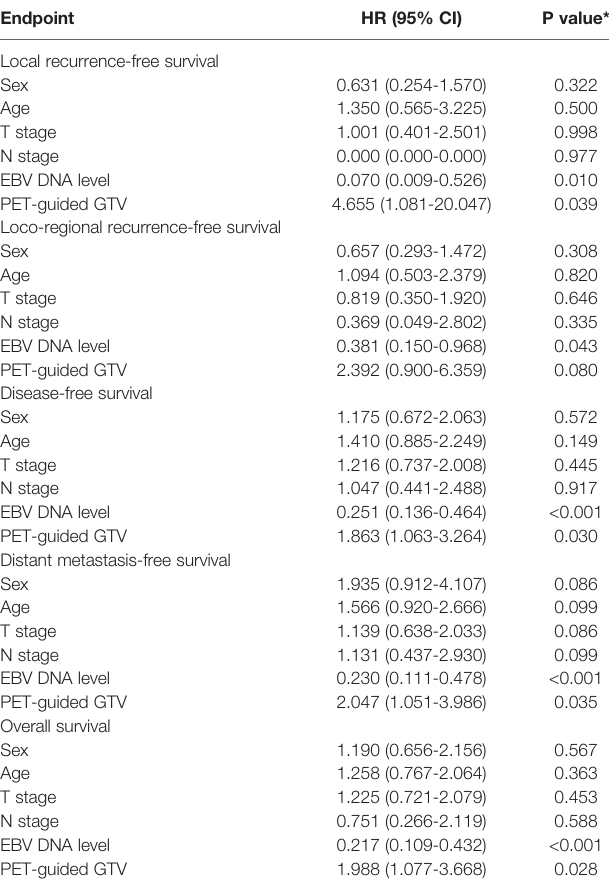
TABLE 3 | Multivariable analysis of prognostic factors in loco-regionally advanced NPC.